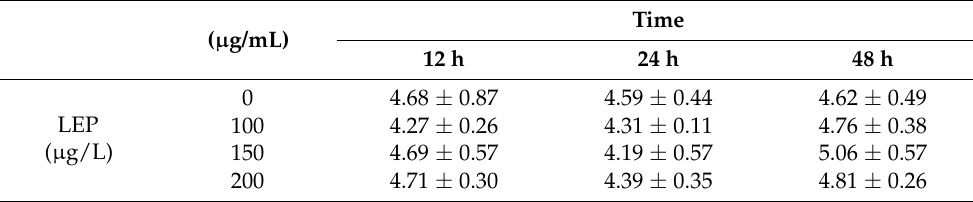
Table 9. Effect of different concentrations of GSP on LEP levels in mature adipocytes.